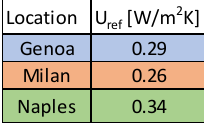
Figure 4. Thermal transmittance in cavity walls with different heat reflective insulating layers (ap- plication in the middle of the air cavity). The red, blue, and green lines represent the threshold for different cities.